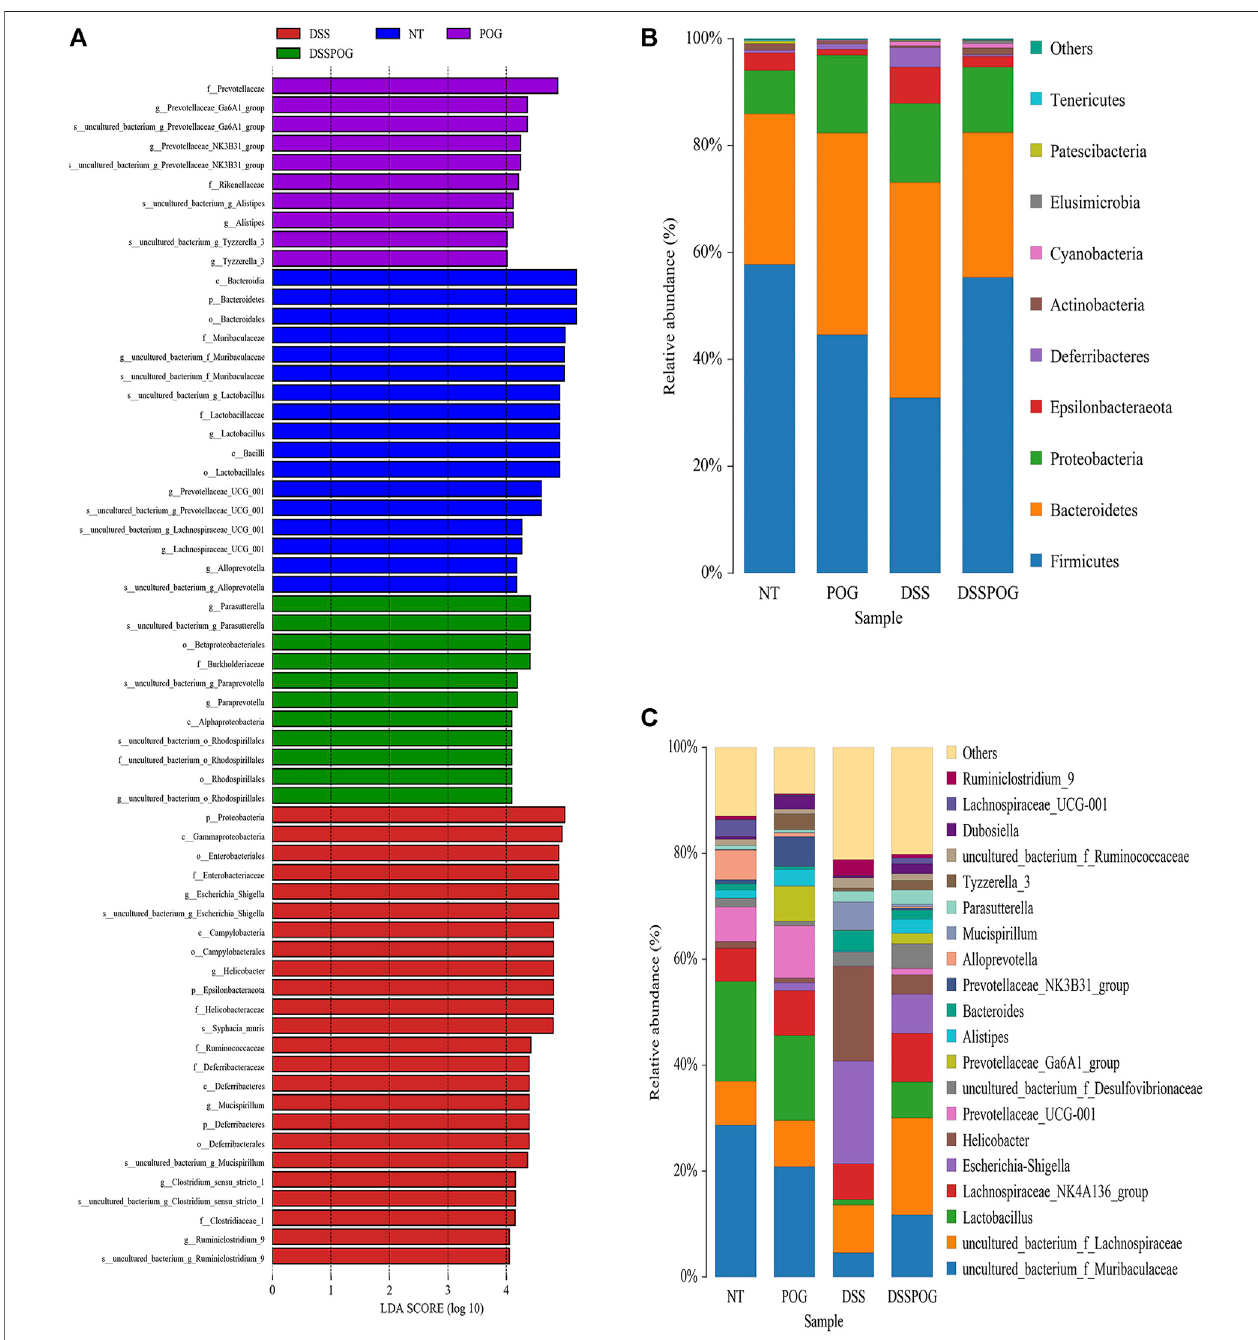
FIGURE 6 | Intestinal microbiome composition analysis of mice in each group. (A) Histogram of LDA value distribution. (B) The top ten phyla of microbial composition in four groups of mice colon samples. (C) The fi rst twenty genera of microorganisms in four groups of mice colon samples.